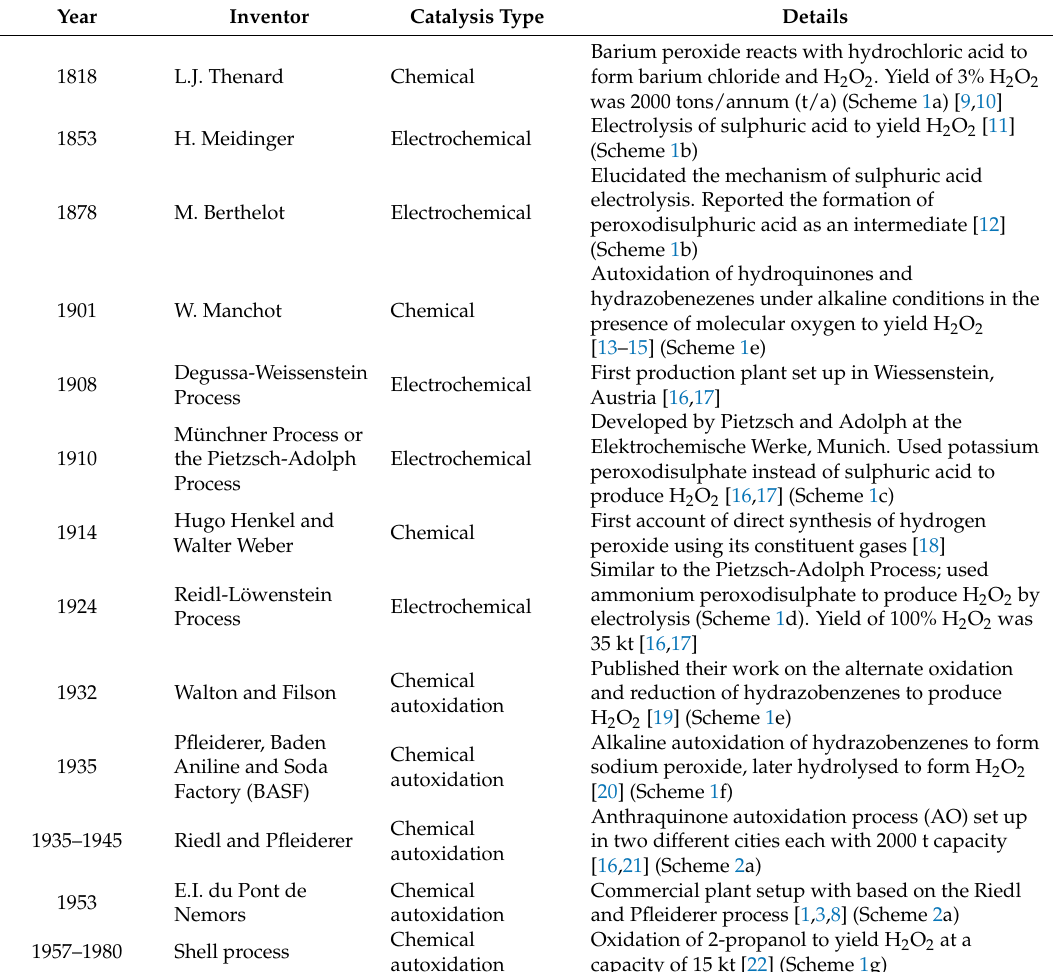
Table 1. Historical development in the industrial manufacture of hydrogen